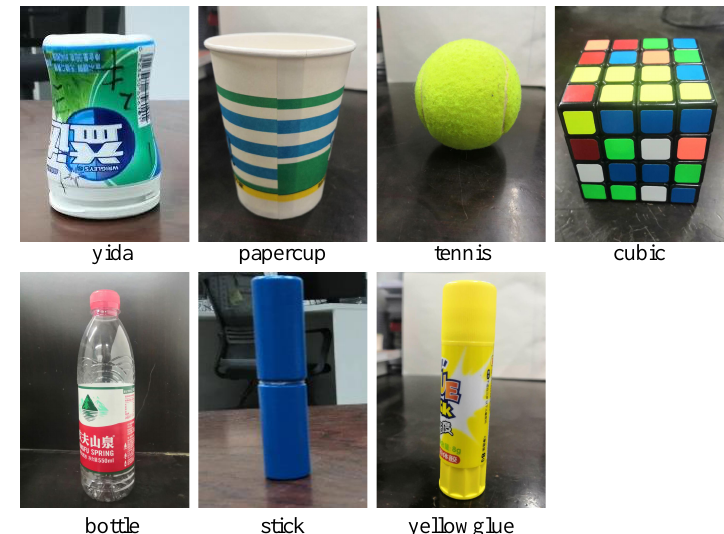
Figure 11. The seven different objects.